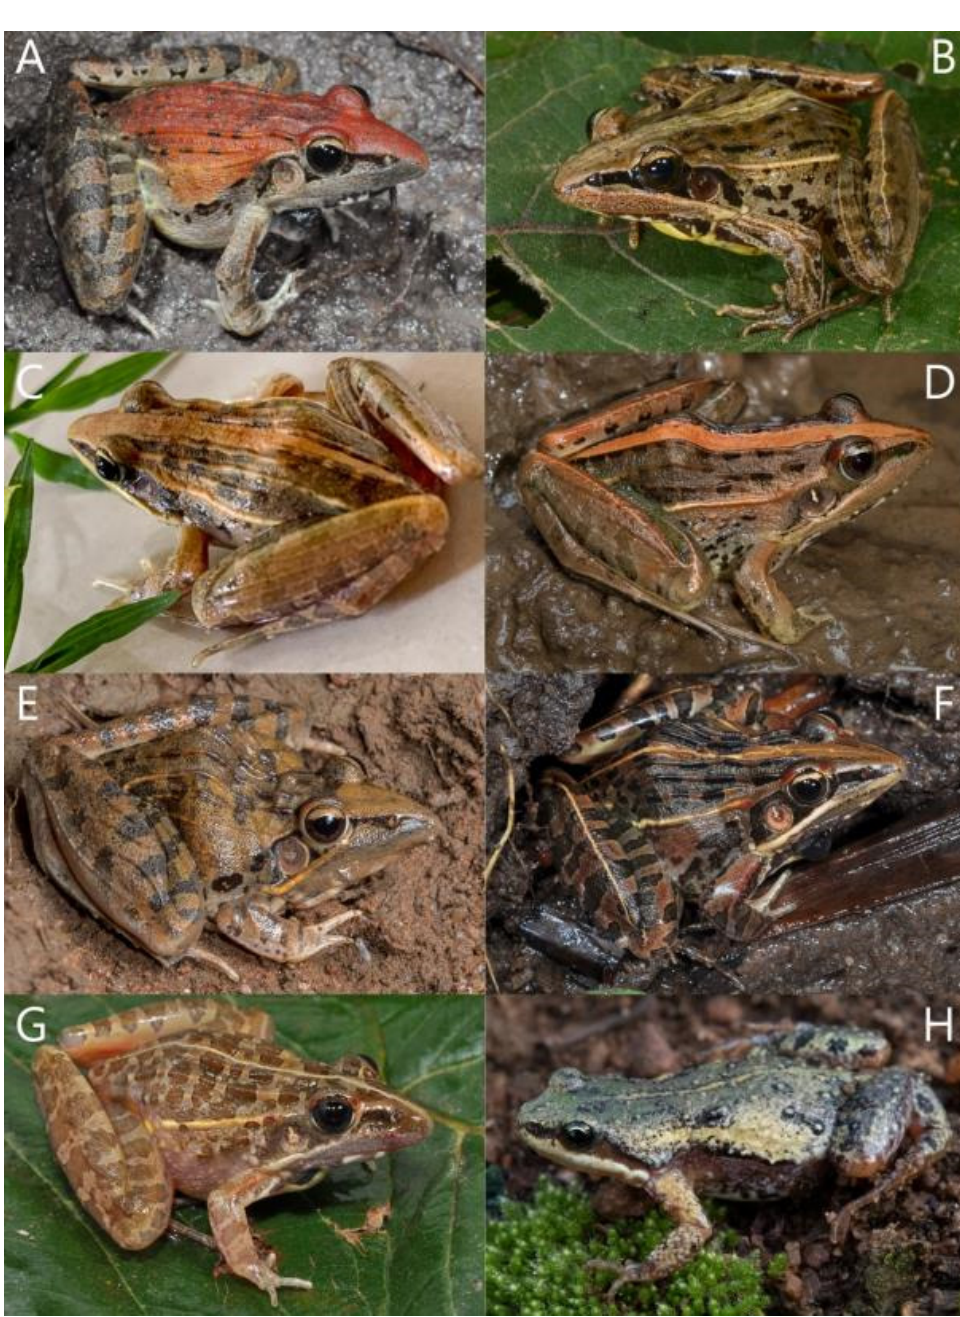
Figure 14. Rwandan species of Ptychadenidae ( A ) Ptychadena anchietae , Huye (photo: J.M.D.), ( B ) Ptychadena chrysogaster , Rugezi Wetland (photo: J.M.D.), ( C ) Ptychadena guibei , Bugarama (photo: Mapendo Mindje), ( D ) Ptychadena nilotica , Mugesera Wetland (photo: J.M.D.), ( E ) Ptychadena oxyrhynchus , Akagera NP (photo: J.M.D.), ( F ) Ptychadena porosissima , Huye (photo: J.M.D.), ( G ) Ptychadena uzungwensis , Huye (photo: J.M.D.); and Pyxicephalidae, ( H ) Cacosternum plimptoni , Akagera NP (photo: J.M.D.).